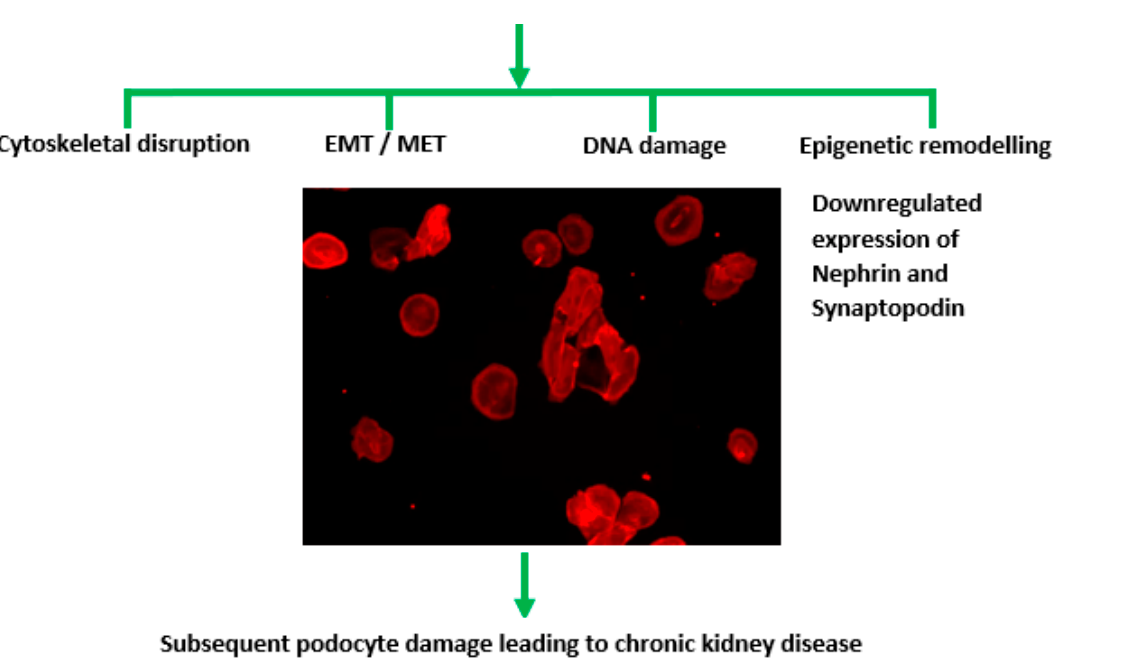
Figure 6. Graphical summary of this study. SIX2-positive renal progenitor cells were isolated directly from human urine and cultured in proliferation medium. UdRPCs differentiated into podocytes, by low density cultivation in advanced RPMI medium supplemented with 30 µ M retinoic acid. Stimulation with 100 µ M ANGII results in cytoskeletal remodeling. Furthermore, the transcriptome revealed altered expression of genes associated with epigenetic remodeling, DNA damage response, EMT, and MET. ANGII activated the renin–angiotensin system, resulting in podocyte damage and loss and ultimately leading to chronic kidney disease.